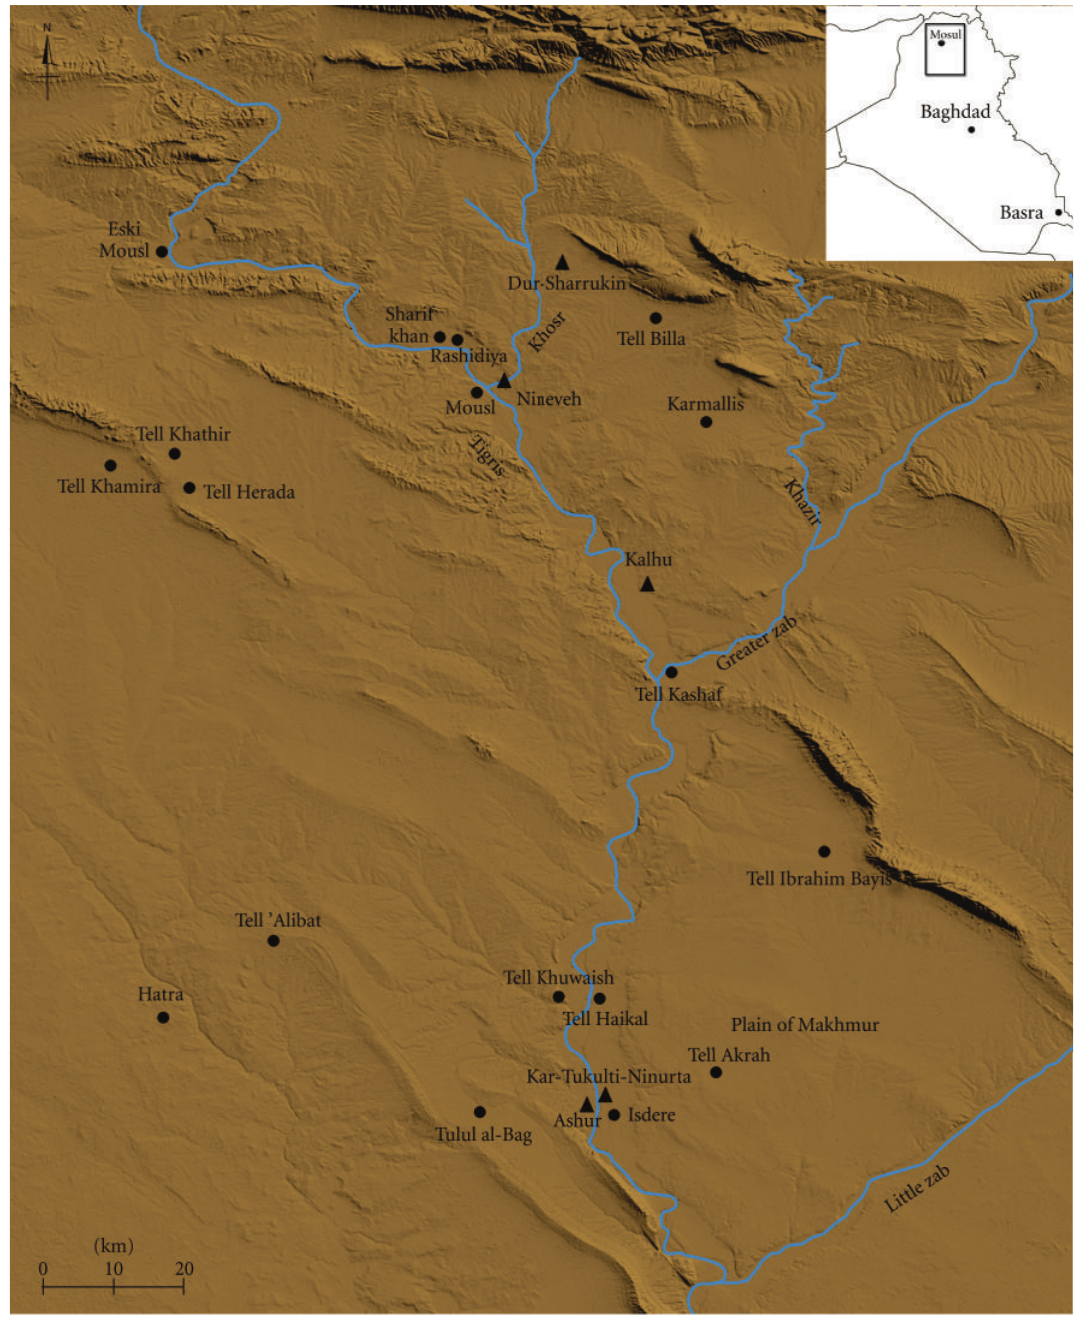
Figure 1: DEM (based on the shuttle radar topography mission) of the northern Iraq: the study area and the Assyrian capital cities along the Tigris valley are